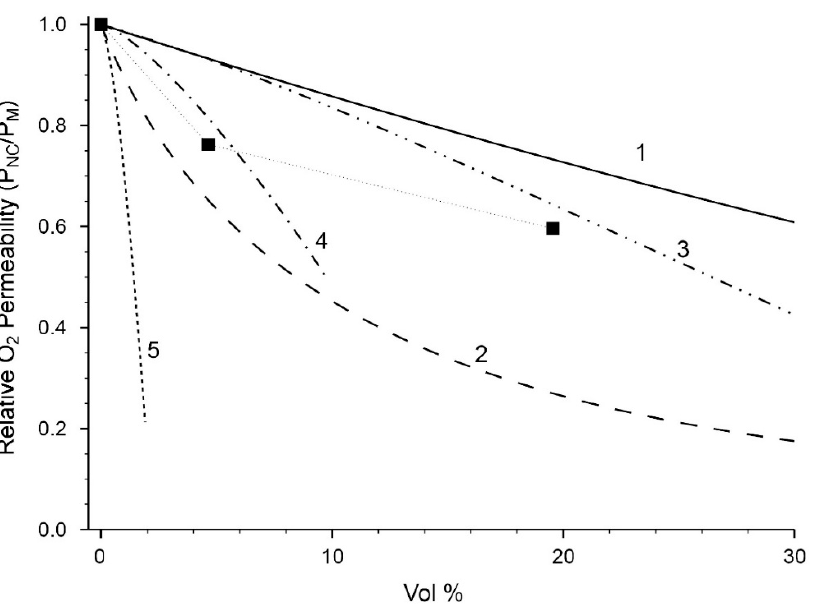
Figure 18. Relative oxygen permeability as a function of vol % of SNT in PIPAA-PM/SNT nanocomposite films. The curves represent theoretical predictions of composites filled with fillers exhibiting different geometries: spherical (1), disks with r/h ј 10 (2), and rods with L/d ј 1 (3), 5 (4) and 20 (5). Note that subscripts NC and M in the y-axis legend represent PIPAA-PM/SNT and PIPAA-PM, respectively, as described in the text [4].